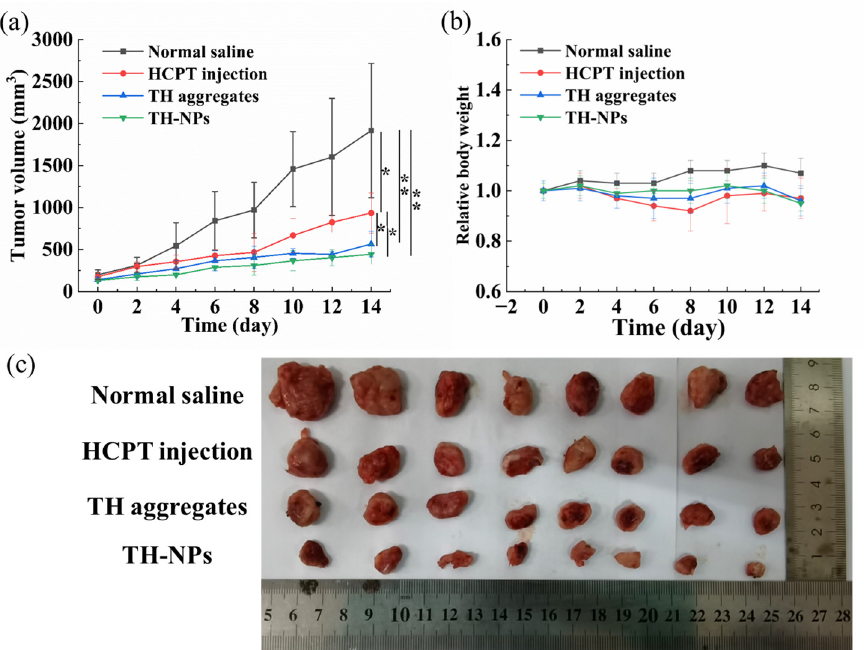
Figure 10. The tumor volume change, * p < 0.05 vs. normal saline. ** p < 0.01 vs. normal saline ( a ) and body weight change of the 4 groups of mice during the dosing period ( b ), and the actual photo of the tumors collected for the 4 groups at the end of the experiment ( c ). Data represent the mean ± SD ( n = 8). Table 1. The antitumor effects against 4T1-bearing BALB/c mice; the results are presented as the